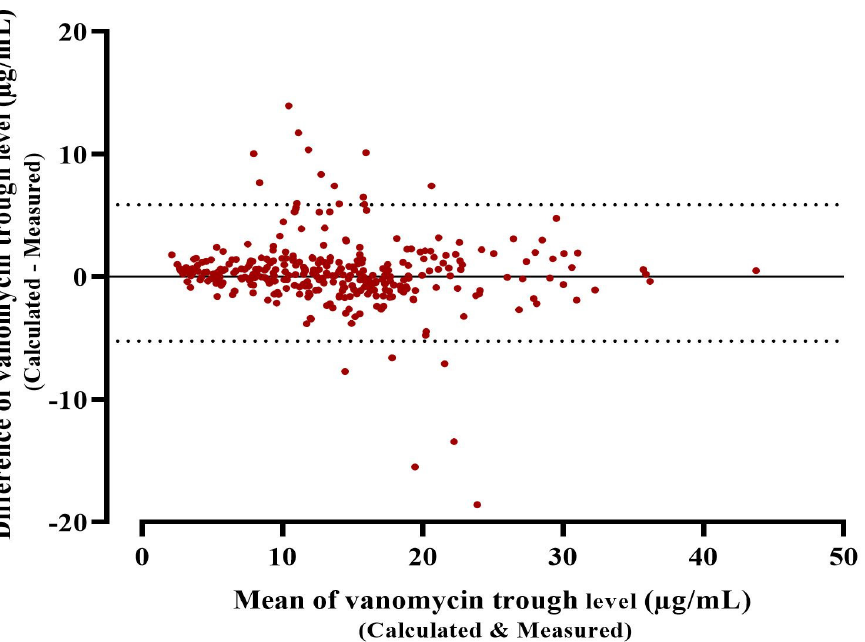
Figure 3. Bland-Altman plot for Bayesian software validity in prediction vancomycin trough. Each sample is represented on the graph by conveying the mean value of the 2 trough levels ( x -axis) and the difference between the 2 trough levels ( y -axis). The mean difference was the estimated bias, and the standard deviation (SD) of the differences measured the fluctuations around this mean (outliers being above 1.96 SD diff). Reference lines show the mean difference between time 1 and time 2 (solid line), and dashed lines represent 95% limits of agreement.